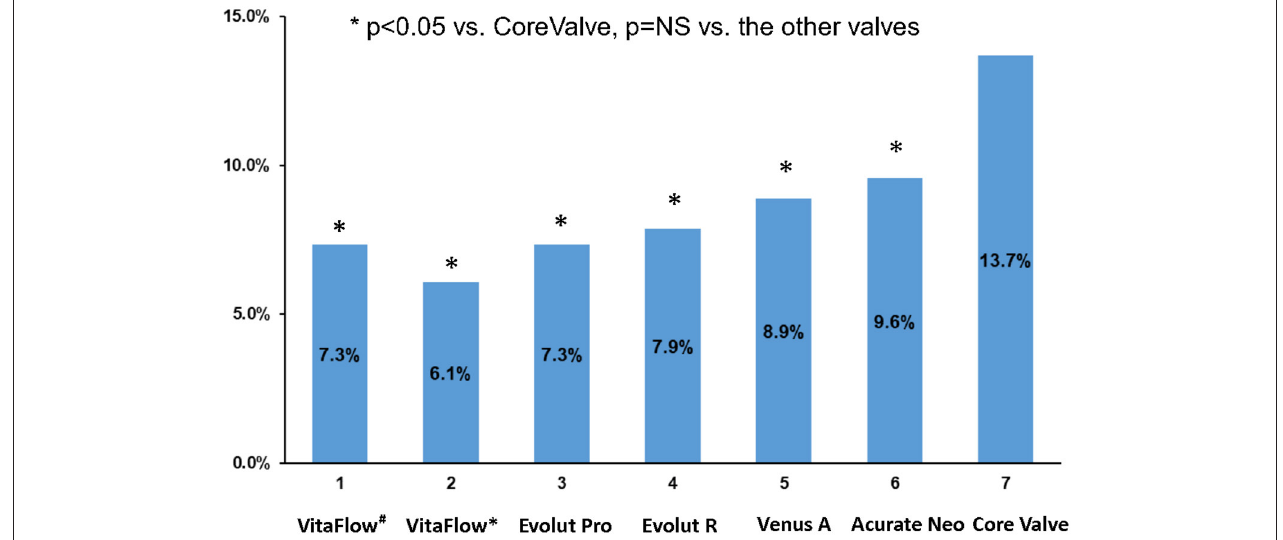
FIGURE 2 | Comparison of the mean LVOT-AR after TAVR among the six THVs. VitaFlow # : the mean LVOT-AR of the intermediate aortograms. VitaFlow*: the mean LVOT-AR of the final aortogram (after the second valve implantation). LVOT-AR, quantitative aortic regurgitation in the left ventricular outflow tract; TAVR, transcatheter aortic valve replacement; THV, transcatheter heart